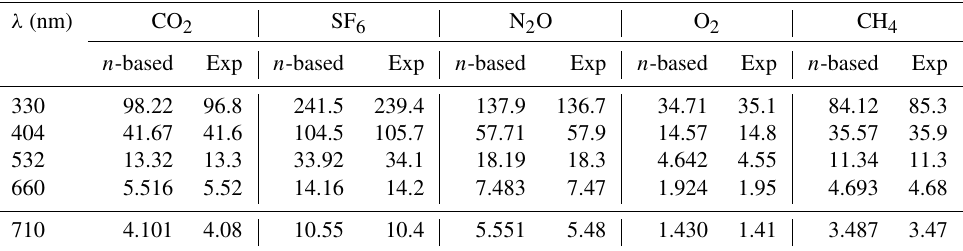
Table 2. The Rayleigh scattering cross sections (10 − 27 cm 2 ) calculated from the refractive index ( n -based) and obtained from BBCES system (Exp) of selected wavelengths.